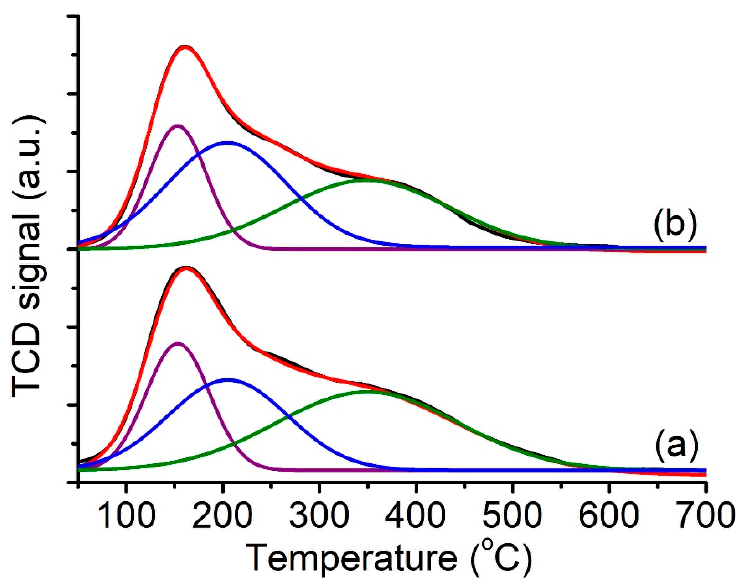
Figure 5. NH 3 -TPD profiles of ( a ) CTA + -offretite and ( b ) TMA + -offretite zeolites after deconvolution, which shows the presence of weak, mild, and strong acid sites. Table 2. Catalytic performance of offretite catalysts in acylation of 2-methylfuran at 170 °C under non-microwave instant heating conditions.